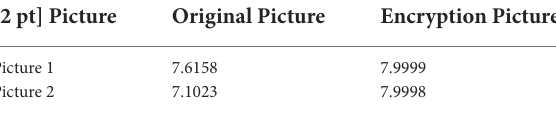
TABLE 4 The information entropy of